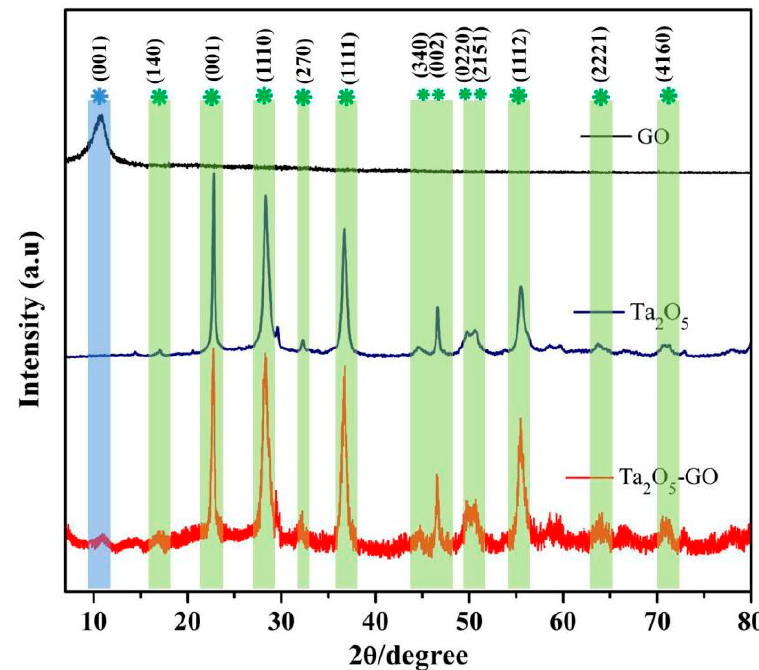
Figure 2. Patterns of pure Ta 2 O 5 , Ta 2 O 5 -GO composites, and graphene oxide (GO) nanosheets.